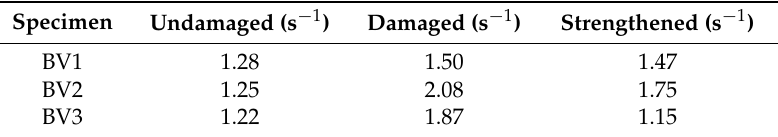
Table 3. Recorded damping values from free oscillations.